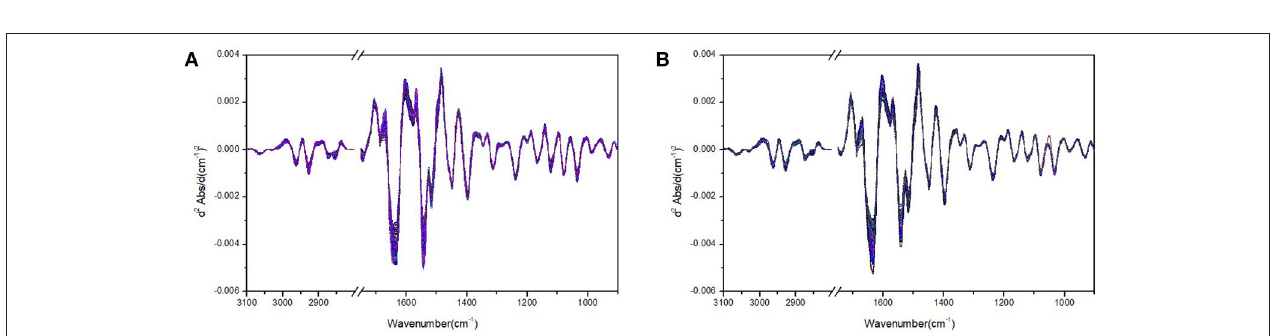
FIGURE 2 | Plasma FTIR second derivative spectra of the rat group without ALP (A) and with ALP (B) in the 3,100–2,800 and 1,750–900 cm − 1 spectral regions.